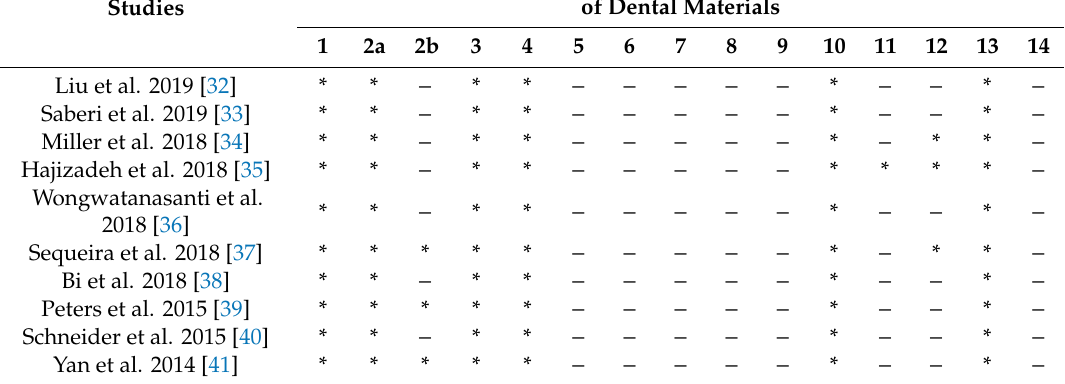
Table 3. Results of the assessment of in vitro studies by the use of the modified CONSORT checklist [31]. Cells marked with an asterisk “*” represent study fulfillment for the given quality assessment parameter. Blank cells represent non-fulfillment. Modified CONSORT Checklist of Items for Reporting in Vitro Studies of Dental Studies